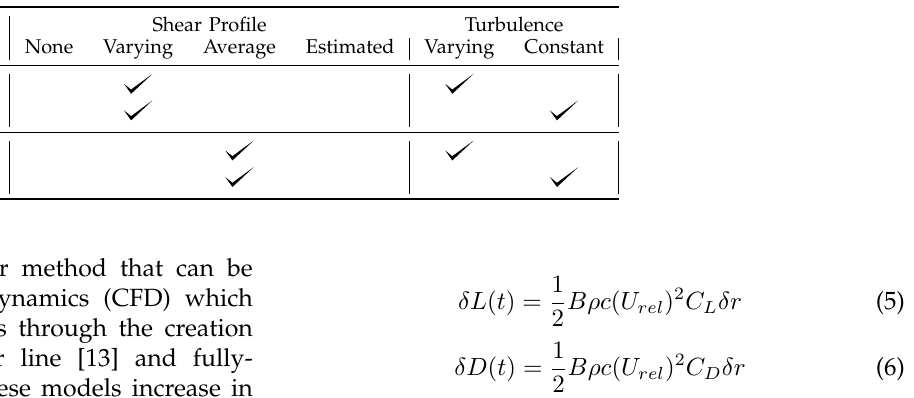
TABLE II S ET UP FOR DIFFERENT CASES IN ORDER TO EXAMINE THE VARIATION IN LOAD FROM EACH CASE